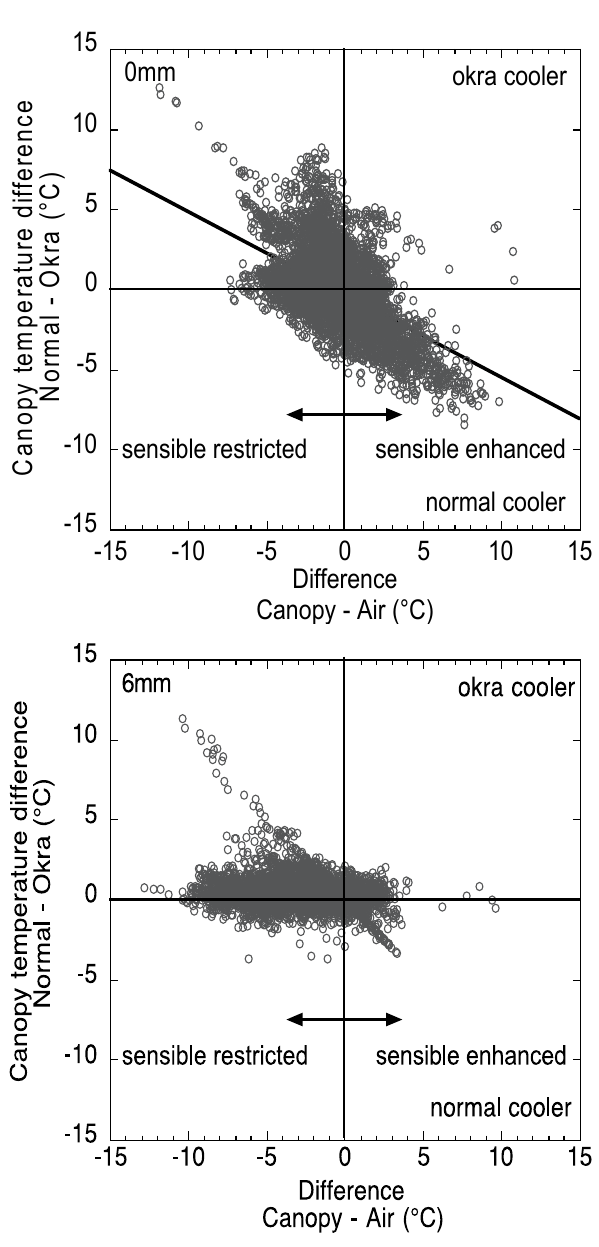
Figure 9. Difference in canopy temperature for okra and normal leaf varieties (normal–okra) as a function of the difference between the canopy temperature of the okra leaf variety and air temperature (okra leaf–air) for the 0 mm and 6 mm irrigation treatments. Positive values on the x-axis indicate increasing capacity for sensible cooling of okra leaf variety. Positive values on the y-axis indicate okra leaf variety cooler than normal leaf variety.